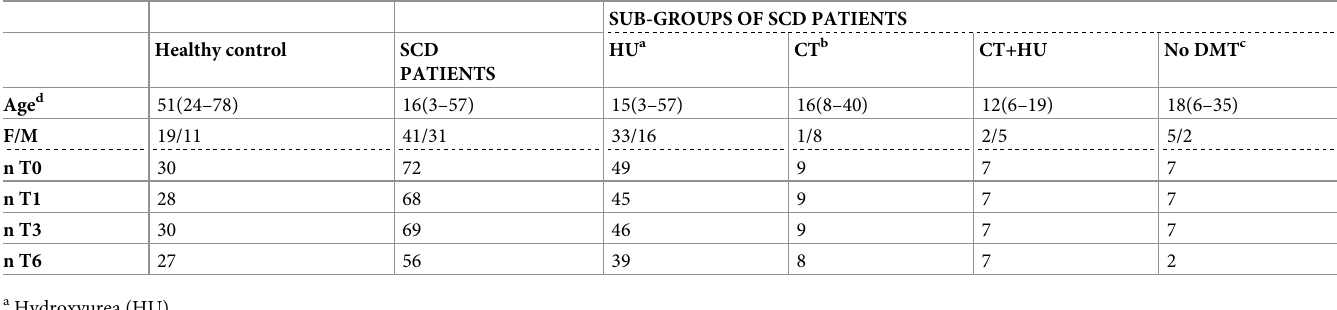
Table 1. Distribution of the subjects participating to the